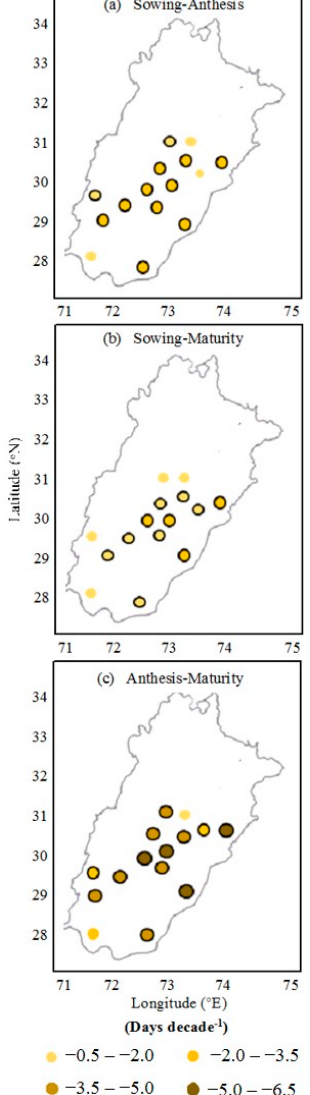
Figure 5. Observed trends in the length of phenological phases for cotton from 1980 to 2015 in Punjab, Pakistan: ( a ) sowing − anthesis; ( b ) anthesis − maturity; and ( c ) sowing − maturity. Circles with black border indicate statistically significant trend at p = 0.05 probability level.